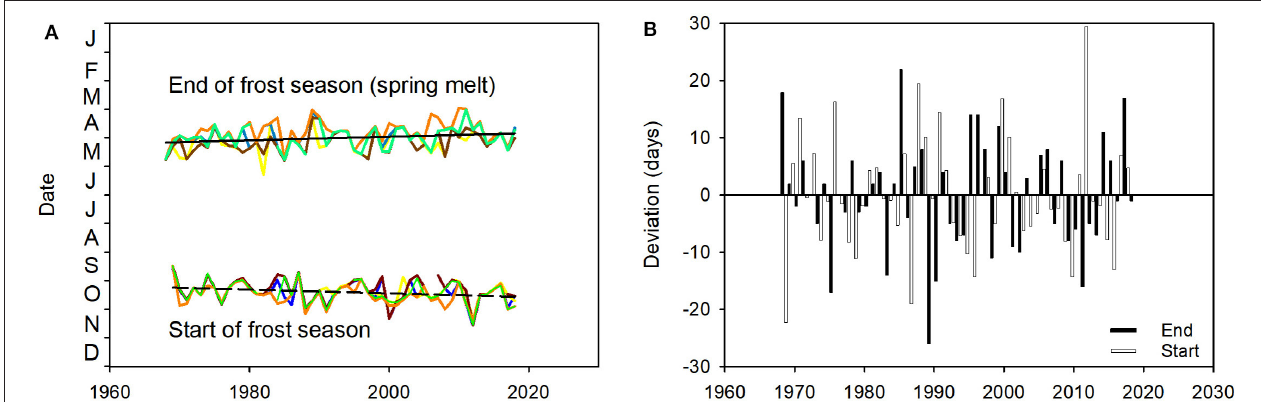
FIGURE 11 | Date of the start of the frost season in autumn and the end of the frost season in spring on the reindeer winter pasture area of Finnmarksvidda ( Figure 7 ), 1969–2018. Data from five weather stations: Cuovddatmohkki, Karasjok, Kautokeino, Sihccajavri and Suolovuopmi ( Figure 7 ). (A) Annual date of start and end, and trends in dates from linear regression models: Date start = [(0.199 · year) – 110.9], r 2 = 0.08, p < 0.05 (straight dashed line) and Date end = [( − 0.188 · year) + 497.2], r 2 = 0.08, p < 0.05 (straight solid line). (B) Annual deviations from the regression models (days; note expanded ordinate scale). For color codes, see Figure 9 .